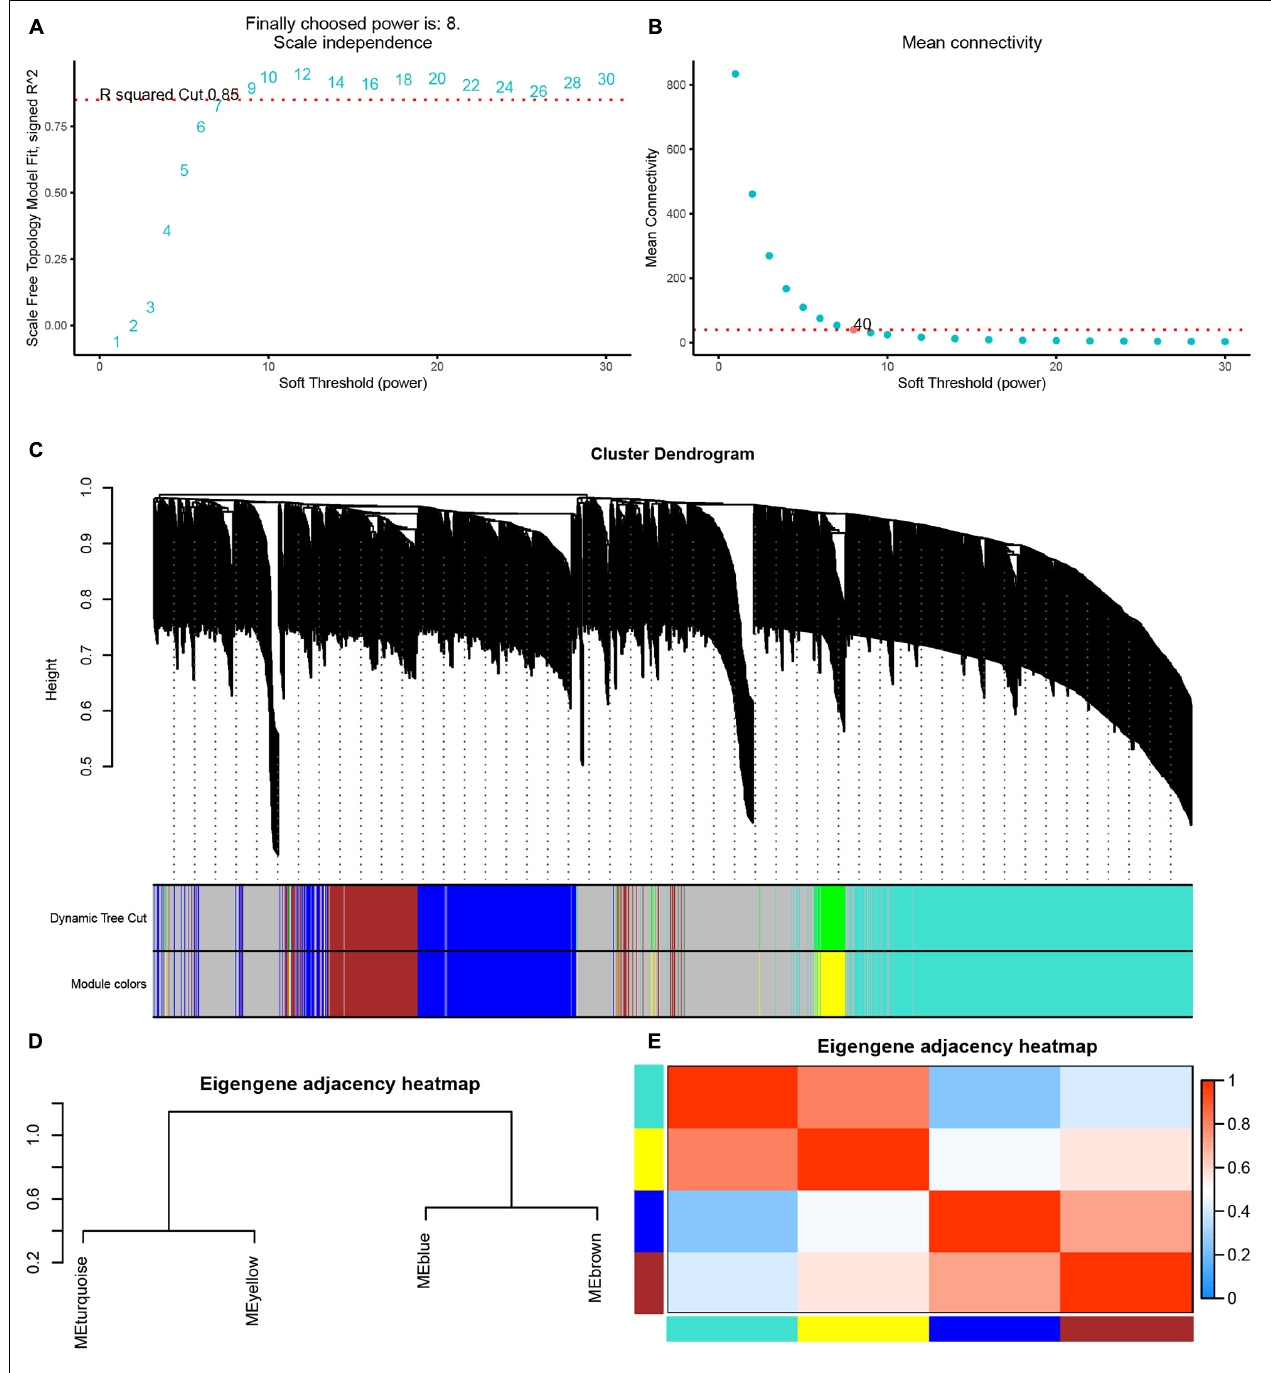
FIGURE 4 | Weighted gene co-expression network analysis of differently expressed genes. (A) The scale-free fit index (left). (B) Mean connectivity (right) for various soft-thresholding powers. (C) Dendrogram of the DEGs clustered based on a dissimilarity measure (1-TOM). (D) Cluster analysis and heatmap of the genes in different modules. (E) Heatmap showing the relationship between module eigengenes.